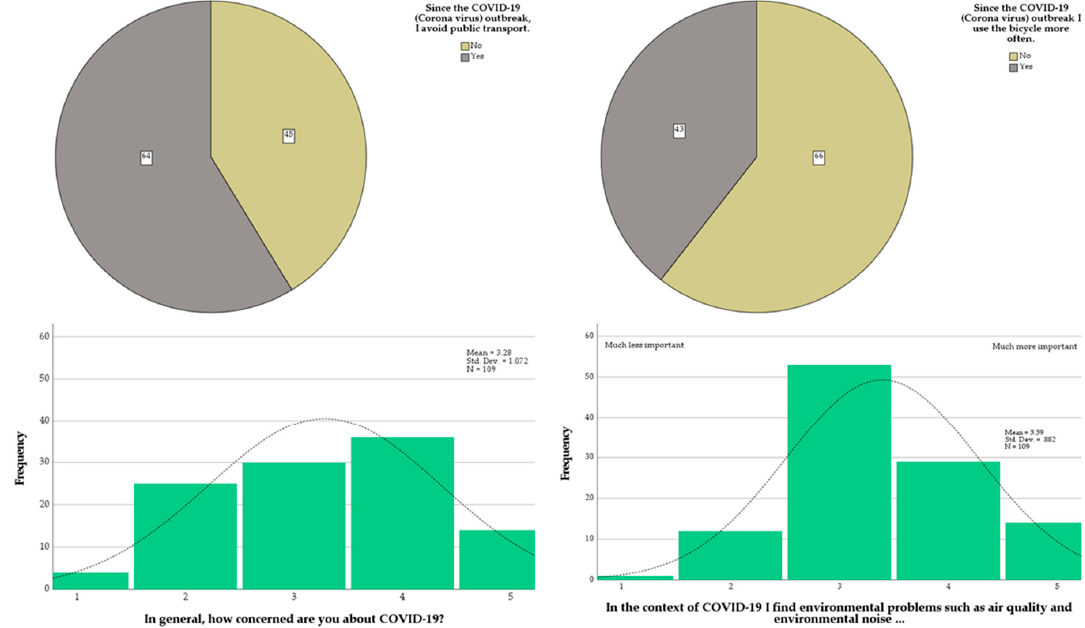
Figure 6. Distributions of the scores for the items of category (e) of the questionnaire.